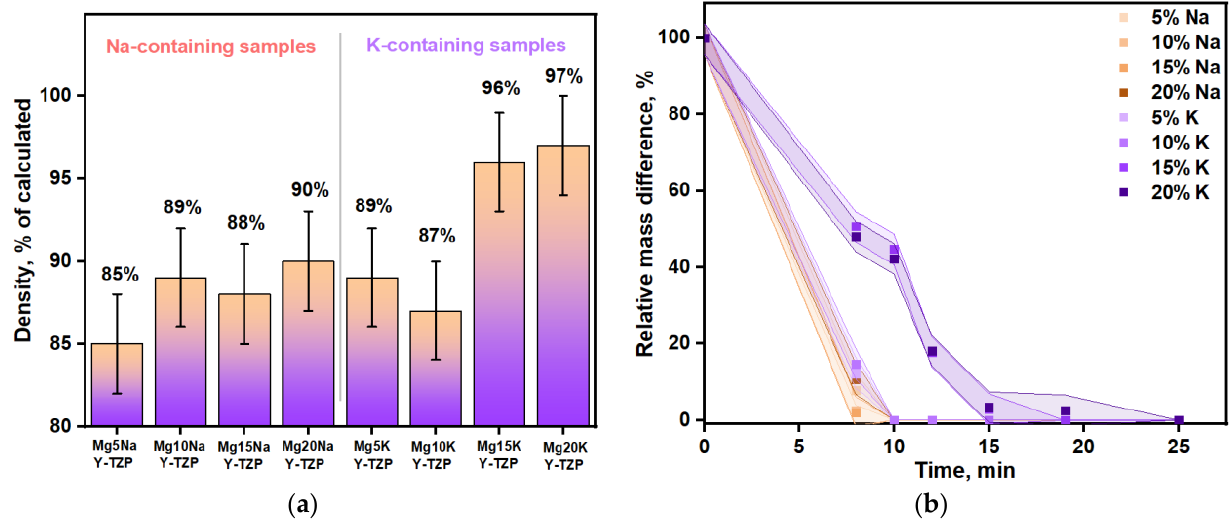
Figure 8. ( a ) Bulk density data; ( b ) mass change during the dissolution process.